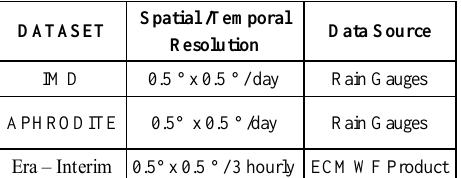
Table 1 Datasets used in the present study